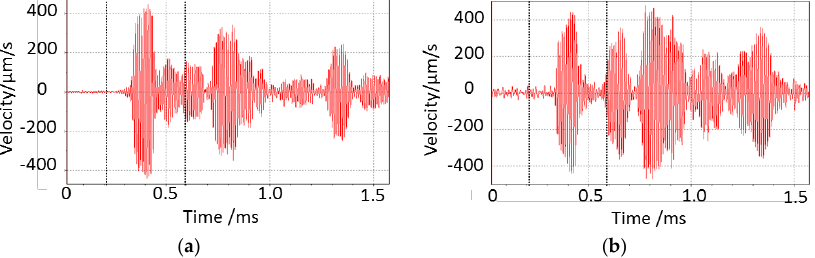
Figure 5. Waveforms from the left hand boundary of the area of investigation in-line with the disbonded region for each panel—( a ) Healthy ( b ) Disbonded. The dashed lines denote the section of waveforms that was used for time windowing.